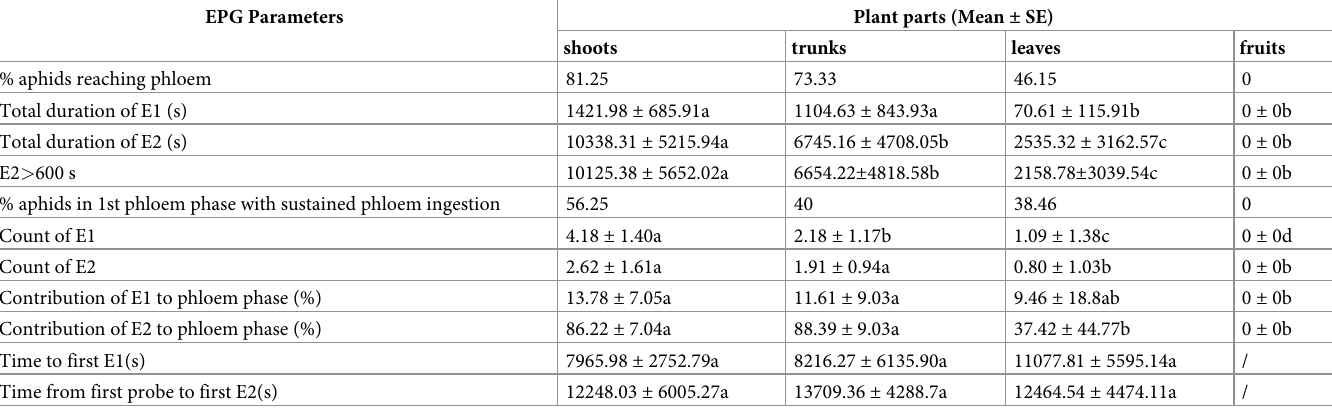
Table 2. Comparison of EPG parameters of woolly apple aphid Eriosoma lanigerum during phloem feeding on four different apple